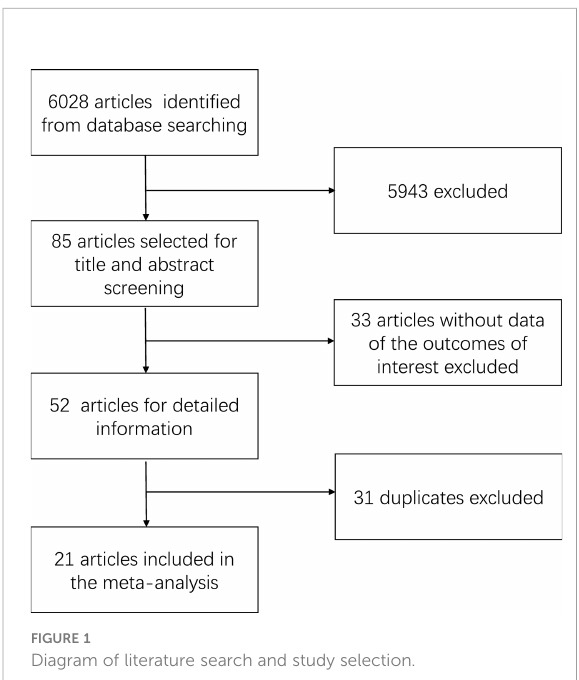
FIGURE 1 Diagram of literature search and study